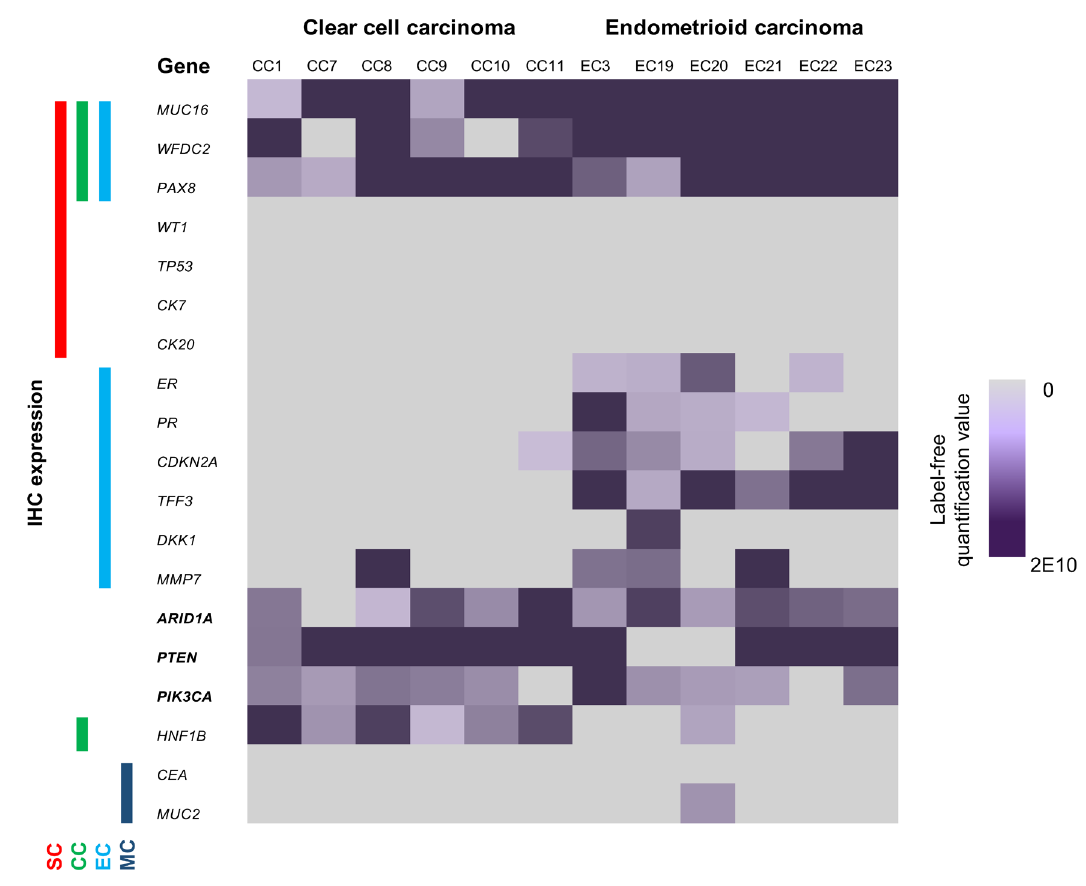
Figure 2. Correlation with immunohistochemical (IHC) markers. An expression matrix demonstrating the correlation of proteomic data with known IHC markers. Label-free quantification values (in arbitrary units represented by the purple gradient scale) were generated from MaxQuant and known IHC markers across the various subtypes were based on collating literature evidence. The expression of the markers across the serous (SC), clear cell (CC), endometrioid (EC) and mucinous (MC) subtypes are denoted by the red, green, blue and indigo lines,